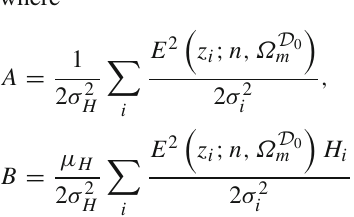
Ω D 0 = 0 . 12 + 0 . 02 m − 0 . 03 . As a